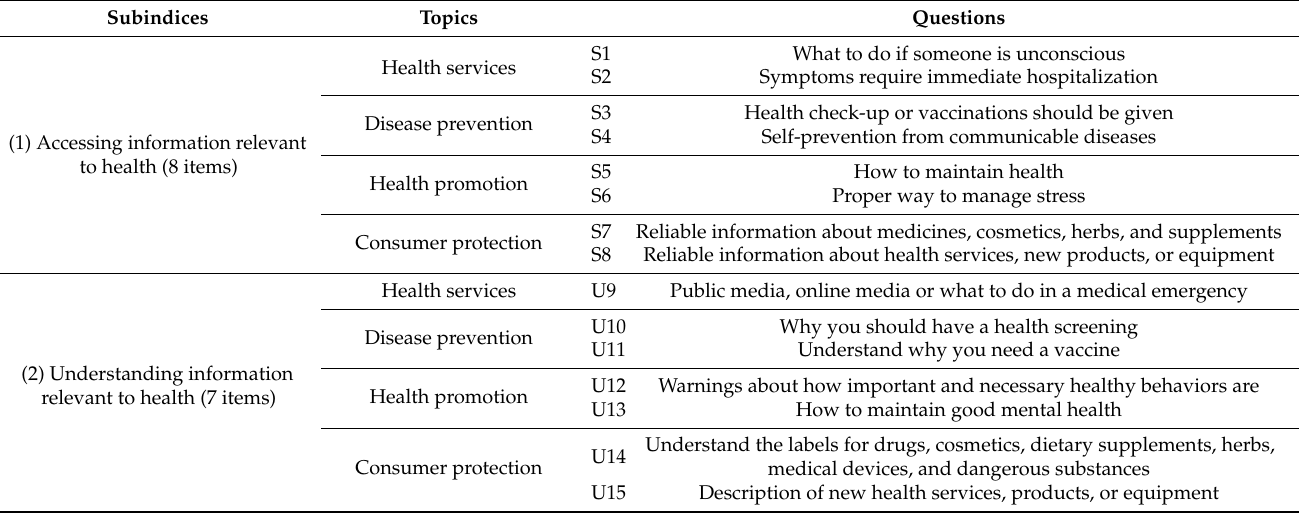
Table 1. The Thai version of the health literacy questionnaire (THLQ)